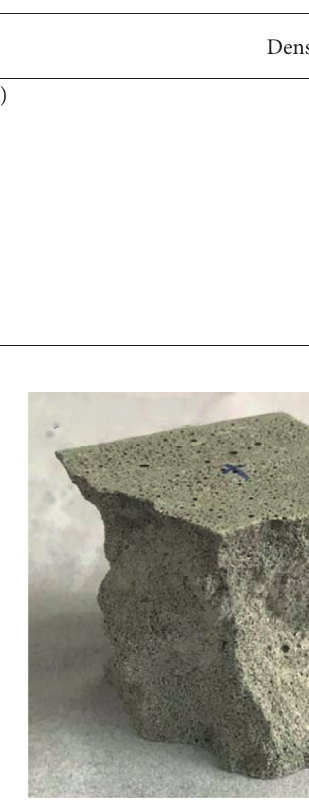
Table 3: Density and compressive strength of LCC.